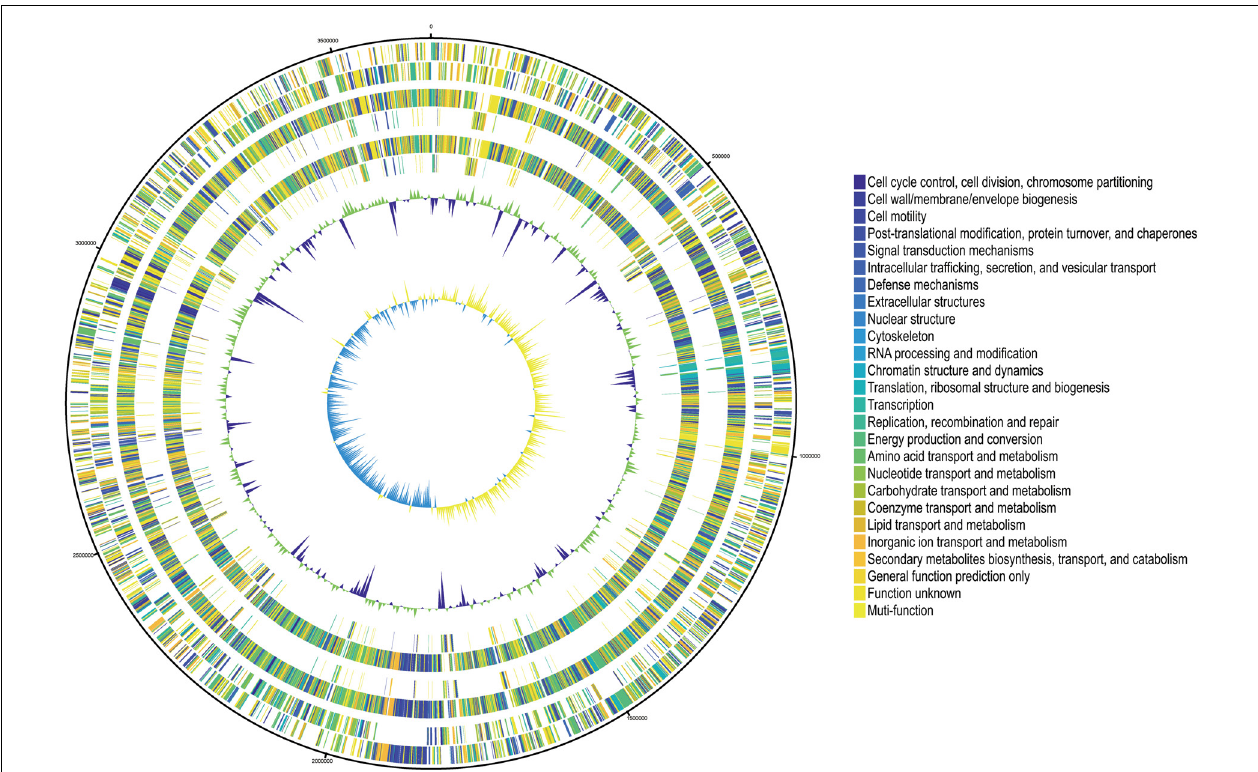
FIGURE 2 | Comparative genome representation of S. acidaminiphila strain SUNEO, JCM 13310, and ZAC14D2_NAIMI4_2. Predicted Coding Sequences (CDSs) are assigned various colors with respect to cellular functions. The Circles display from the outermost to the innermost: (1) DNA coordinates. (2,3) Function-based color coded mapping of the CDSs predicted on the forward and reverse strands, respectively. (4) Orthologous CDSs shared between S. acidaminiphila strain SUNEO and S. acidaminiphila strain JCM 13310. (5) Specific CDSs in S. acidaminiphila strain SUNEO, compared with S. acidaminiphila strain JCM 13310. (6) Orthologous CDSs shared between S. acidaminiphila strain SUNEO and S. acidaminiphila strain ZAC14D2_NAIMI4_2. (7) Specific CDSs in S. acidaminiphila strain SUNEO, compared with S. acidaminiphila strain ZAC14D2_NAIMI4_2. (8) GC plot with regions above and below average in green and Violet, respectively. (window size: 10,000 bp). (9) GC skew showing regions above and below average in yellow and light blue, respectively. (window size: 10,000